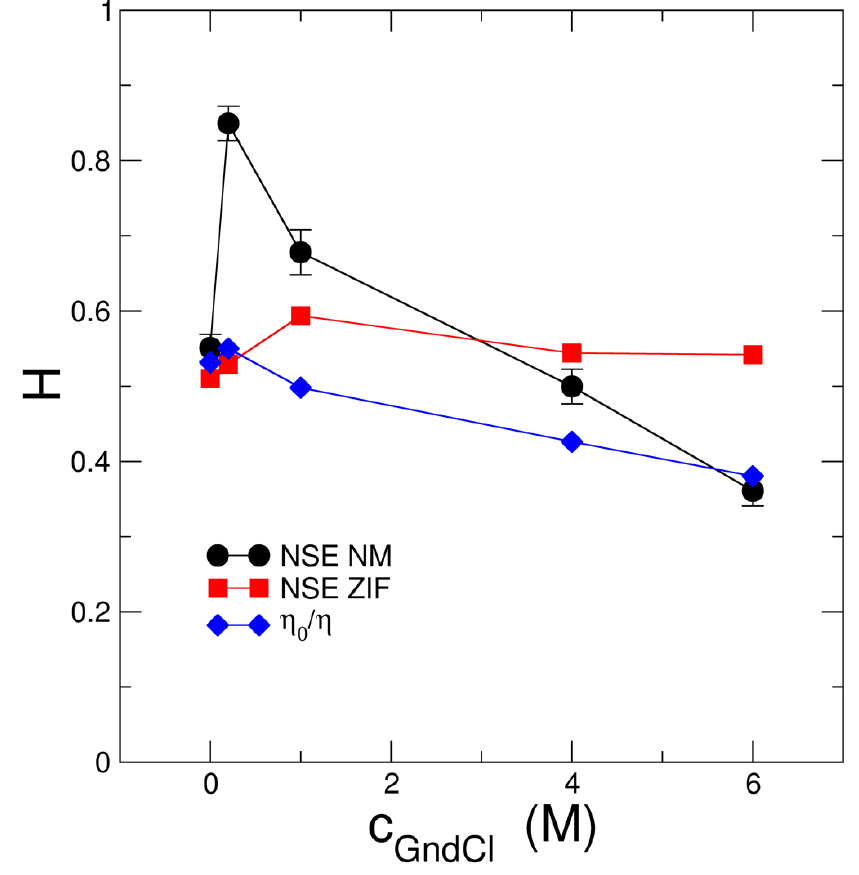
Figure 5. Hydrodynamic function H short obtained from fits of the NSE data using the ZIF model (NSE ZIF) and NM analysis (NSE NM) as compared to macroscopic hydrodynamic behavior as determined by the relation H long = η 0 / η of η 0 buffer and η protein solutions.